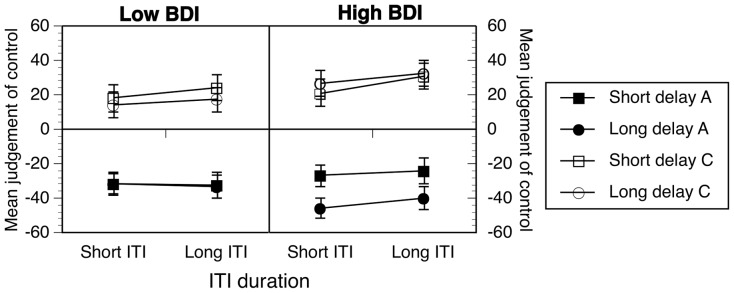
Effects of ITI length and delay duration on ratings of negative (25/75) contingencies.Data are combined across Experiments 4a and 4b. Error bars correspond to the standard error of the mean. A  =  action ratings, C  =  context ratings.